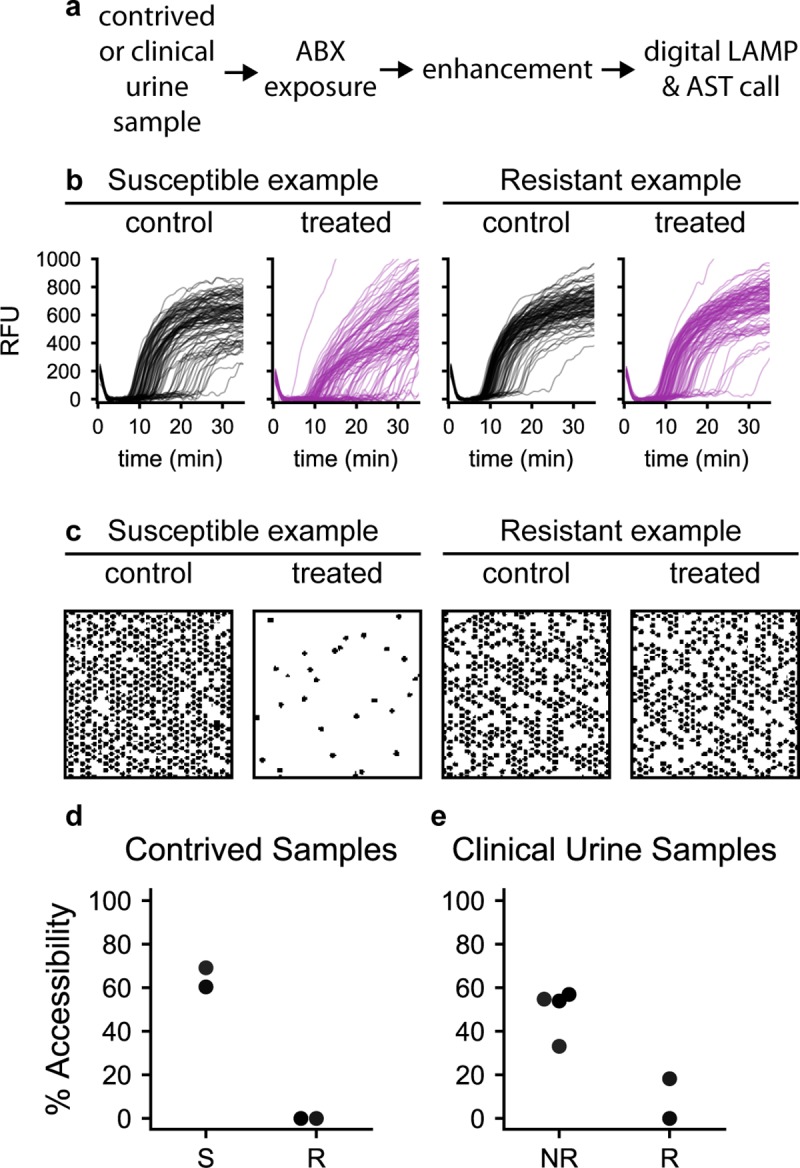
The nuc-aAST workflow for contrived and clinical urine samples with each step timed.(a) The nuc-aAST workflow times required for contrived samples are 15-min ABX exposure, 5-min enhancement, 2 min for DNA extraction, 8 min for digital LAMP and AST call; timing for clinical urine samples includes 30-min ABX exposure, 3–5-min enhancement, 10 min for extraction, and 20 min for digital LAMP and AST call. (b) Amplification curves from which positive wells were determined and counted (a subset of 100 wells is shown for each microfluidic chip, S1–S4 Data) (c) A 2 × 2-mm subsection of masks was created from chips used for performing digital LAMP on control and antibiotic-treated aliquots of S and R samples; as an illustration, each mask shows approximately 625 wells (out of about 20,000 total wells) after 10 min of amplification. Wells that showed amplification of Ng DNA appear black. (d) The percentage of accessible DNA was determined at earliest significance (7–8 min of amplification; see Methods and S5 Table) for two penicillin-S and two penicillin-R samples run using digital LAMP (S5 Table). Each step was timed individually, and the sum of steps of the assay was 30 min. (e) Percentage accessibility was determined after 20 min of digital LAMP for a representative technical replicate for each of the six nuc-aAST performed directly on four clinical urine samples. Ceftriaxone-S and penicillin-intermediate samples are plotted together as NR (S5 Table; MICs are in S1 Table). ABX, antibiotic; AST, antibiotic susceptibility testing; LAMP, loop-mediated isothermal amplification; MIC, minimum inhibitory concentration; Ng, N. gonorrhoeae; NR, not resistant; nuc-aAST, nuclease-accessibility AST; R, resistant; RFU, relative fluorescence units; S, susceptible.